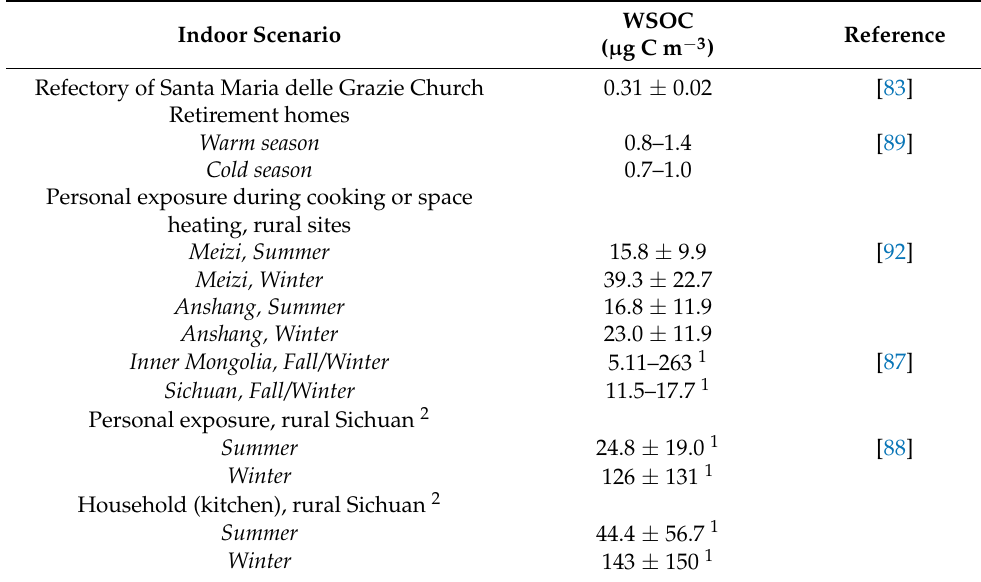
Table 2. Average indoor concentrations (either range or average values) of WSOC in PM 2.5 collected under different indoor